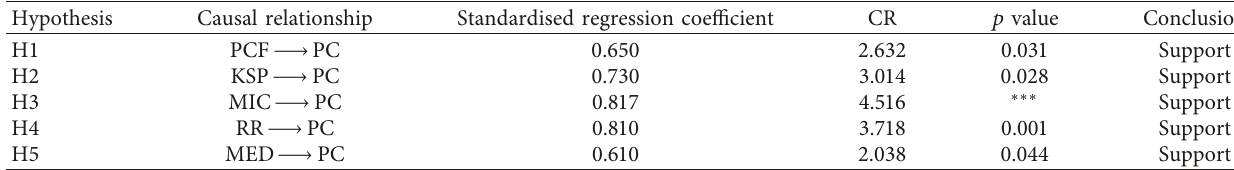
Table 5: Hypothesis testing